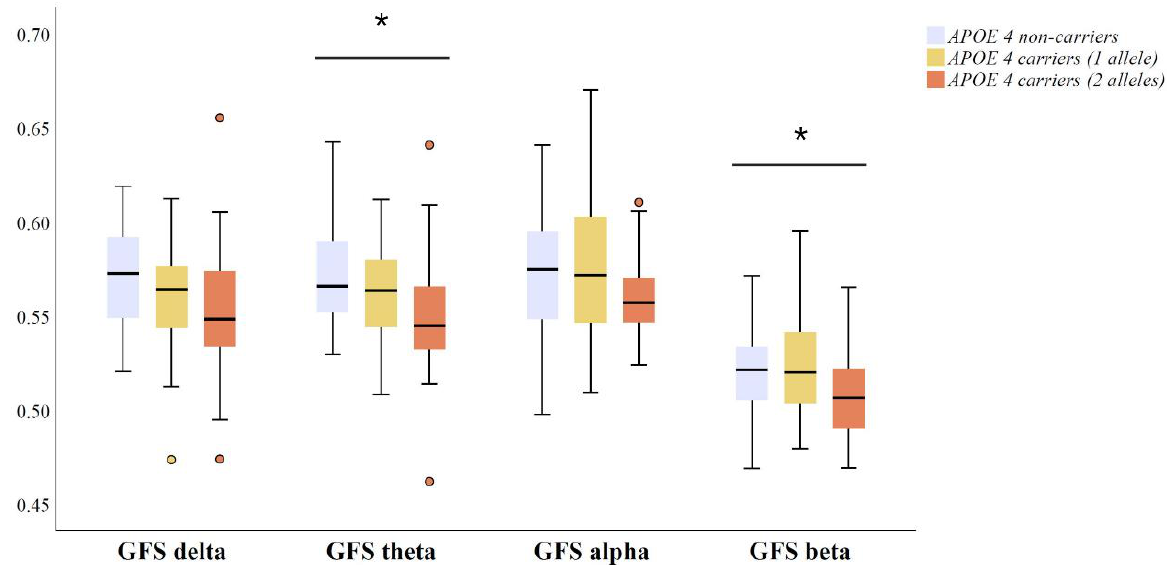
Figure 2. Differences in qEEG measures of global field synchronization (GFS) between APOE ε4 carriers with two alleles ( n = 28), carriers with one allele ( n = 42) and non-carriers ( n = 31), including CSF Aβ42 positive (<550 ng/L) MCI and AD patients. The original data on GFS are presented as the median (solid line), interquartile range (box), and minimum and maximum values (whiskers) across four conventional frequency bands. P-values are based on ANOVA over the three genotype groups; * p < 0.05. Outlier and extreme values are denoted as circles and stars, respectively. Abbreviations: ANOVA = analysis of variance; and APOE = apolipoprotein E.